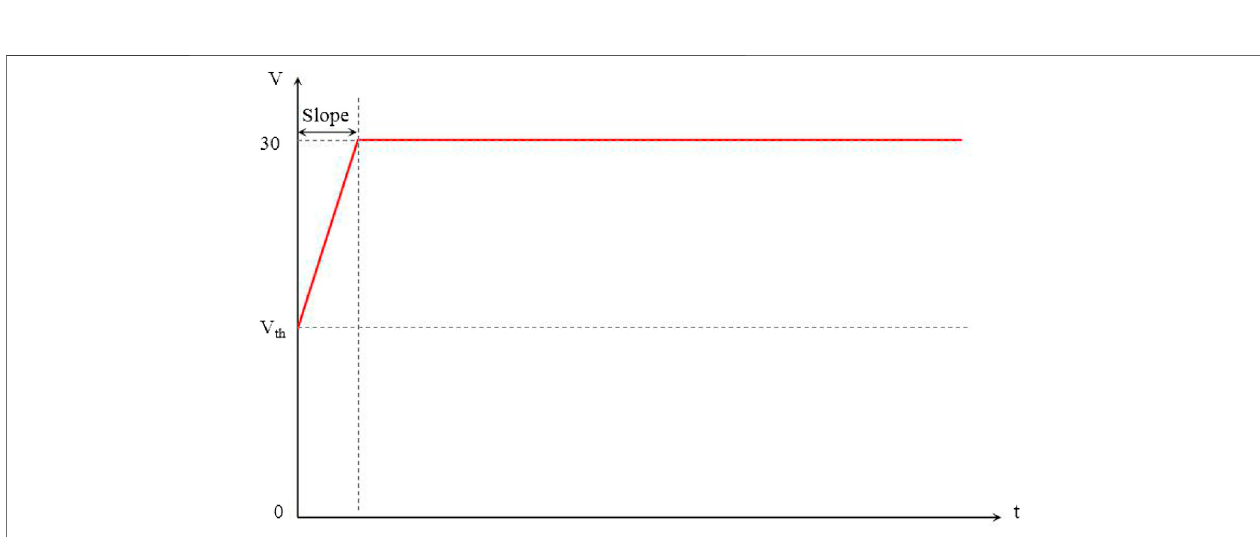
Frontiers in Physics |